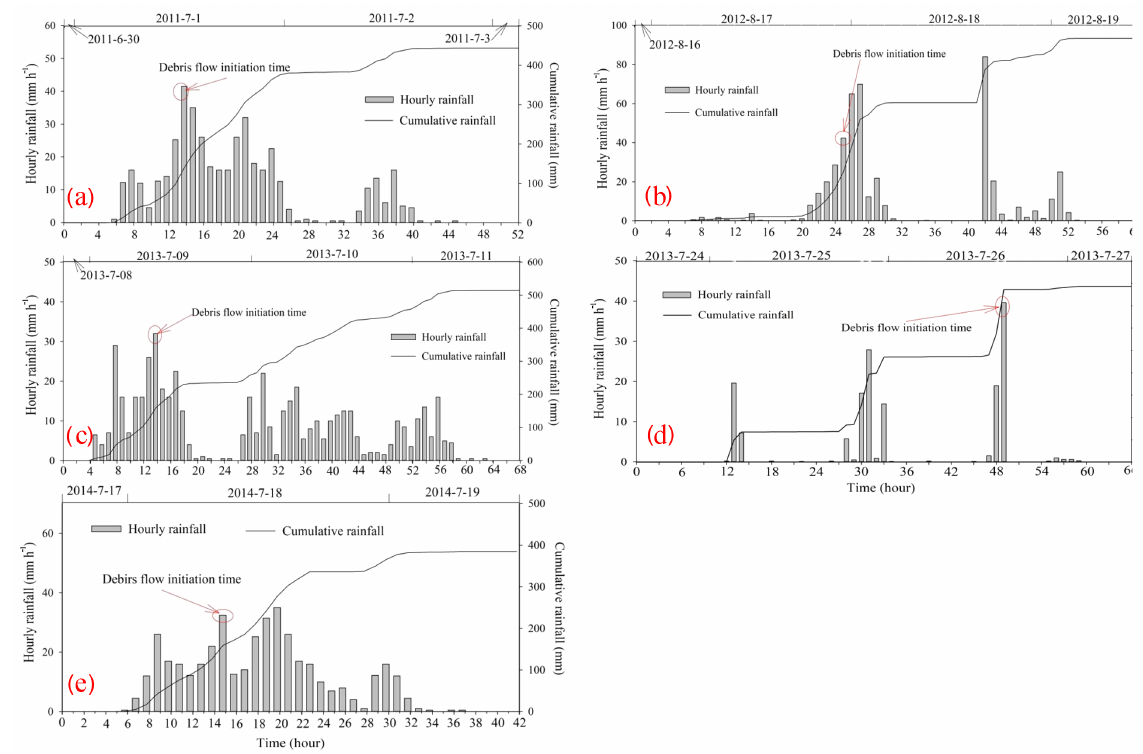
Figure 13. The rainfall process of debris flow events in the Guojuanyan gully from 2011 to 2014 ( a 1 July 2011; b 17 August 2012; c 9 July 2013; d 26 July 2013; e 18 July 2014).